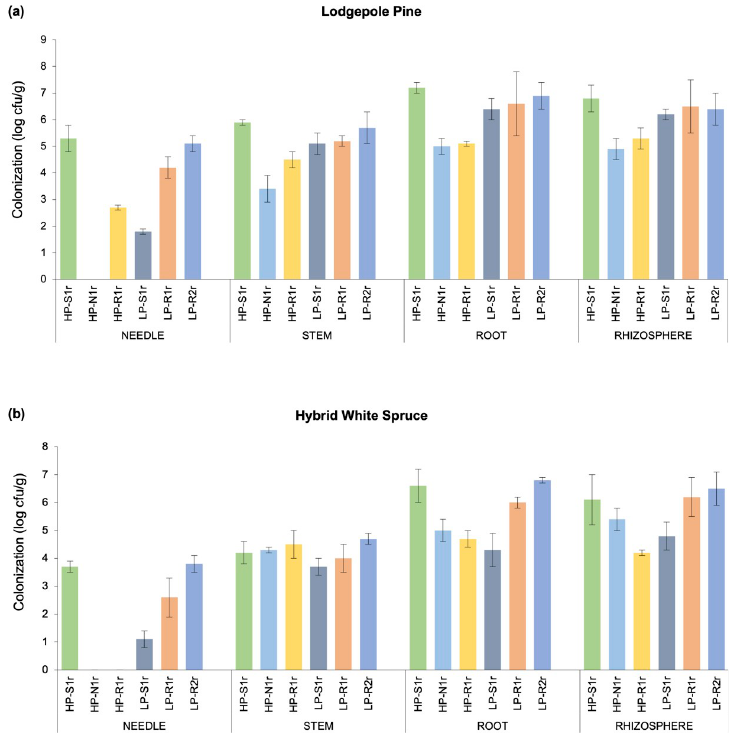
Fig 3. Population density of each of the six bacterial strains ( Caballeronia sordidicola HP-S1r, Pseudomonas frederiksbergensis HP-N1r, Phyllobacterium myrsinacearum HP-R1r, Pseudomonas mandelii LP-S1r, Paraburkholderia phytofirmans LP-R1r and Caballeronia udeis LP-R2r) inside the endophytic tissues (needle, stem and root) and in the rhizosphere of (a) lodgepole pine and (b) hybrid white spruce seedlings evaluated 540 days after inoculation. For clarity of presentation, the data was log-transformed. Error bars represent standard errors of the mean (n = 5 seedlings per treatment for endophytic colonization and 5 seedlings per treatment for rhizospheric